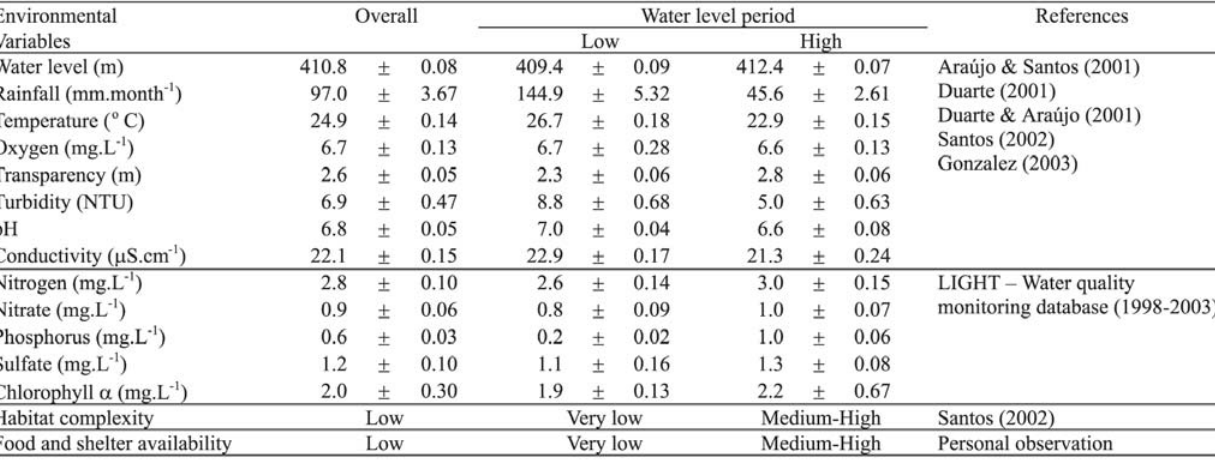
Table 1. Major physical and chemical characteristics (means ± standard error) of the Lajes Reservoir, with differences between low and high water levels